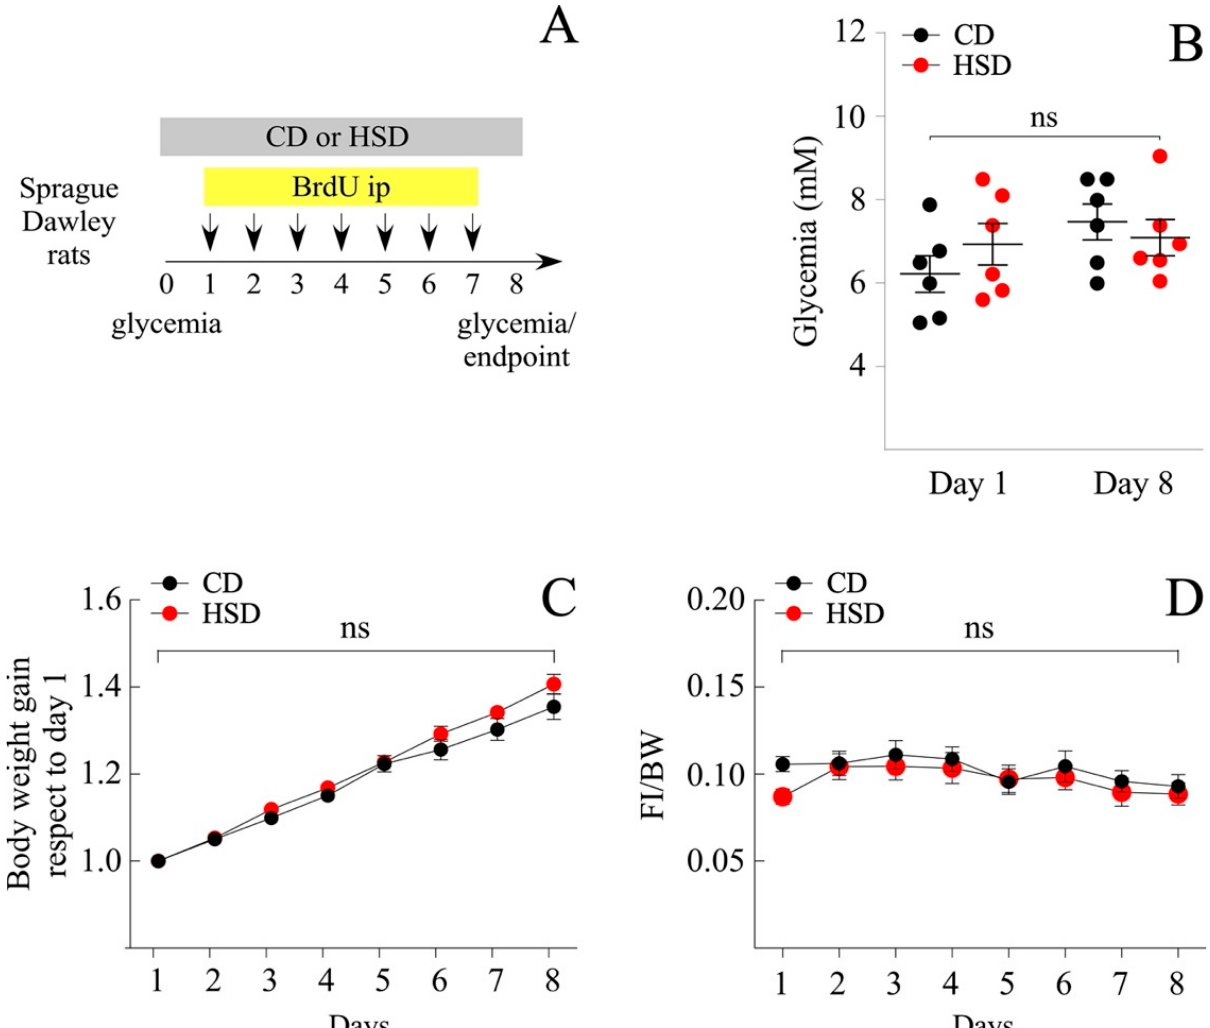
Figure 1. Analysis of metabolic parameters of male rats subjected to HSD. Daily ip injections of BrdU, simultaneous to the exposure of rats to a diet rich in sucrose (HSD) and to a control diet (CD), were carried out as indicated in ( A ). ( B ) Glycemic values (mM) at the beginning and end of the experiment, fasting the rats for 4 h prior to measurement. n = 6 animals per condition. ( C ) Body weight gain over time with respect to day 1 and ( D ) food intake over time with respect to body weight. n = 9 animals per condition. The data is represented as the mean ± sem; p < 0.01; Student’s t- test.